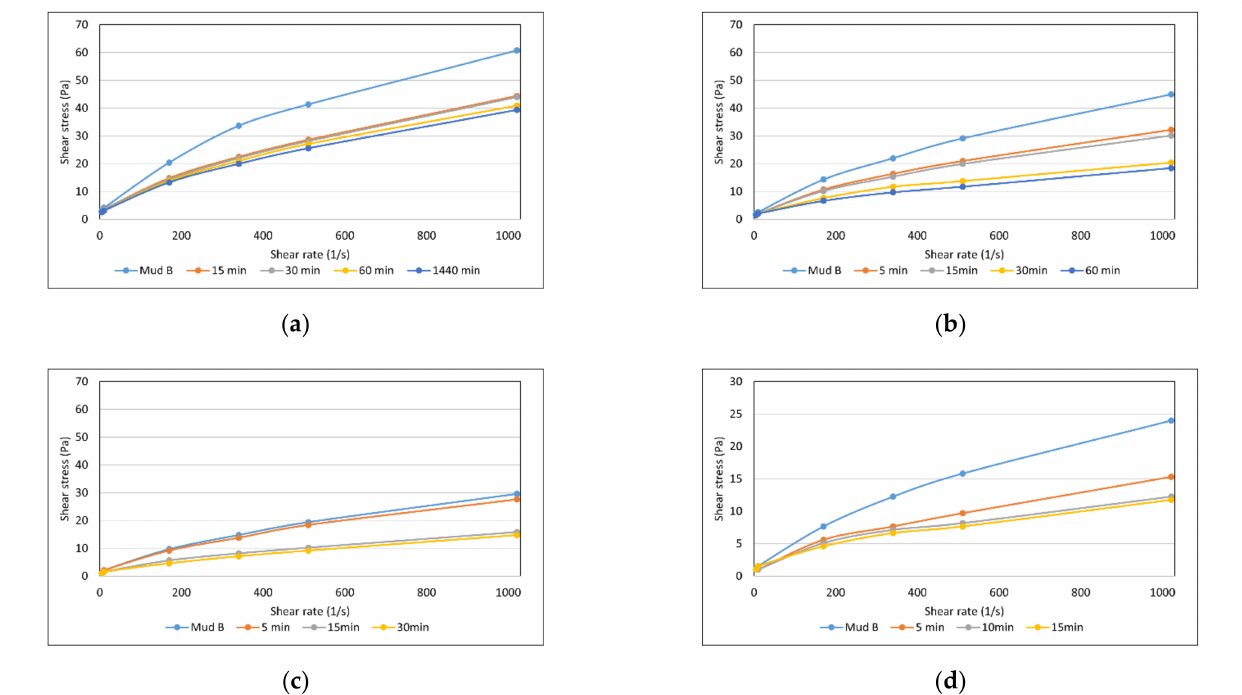
Figure 7. Flow curves of drilling mud B with 1.0% sodium persulfate: ( a ) at 20 ◦ C, ( b ) at 40 ◦ C, ( c ) at 60 ◦ C, ( d ) at 80 ◦ C.